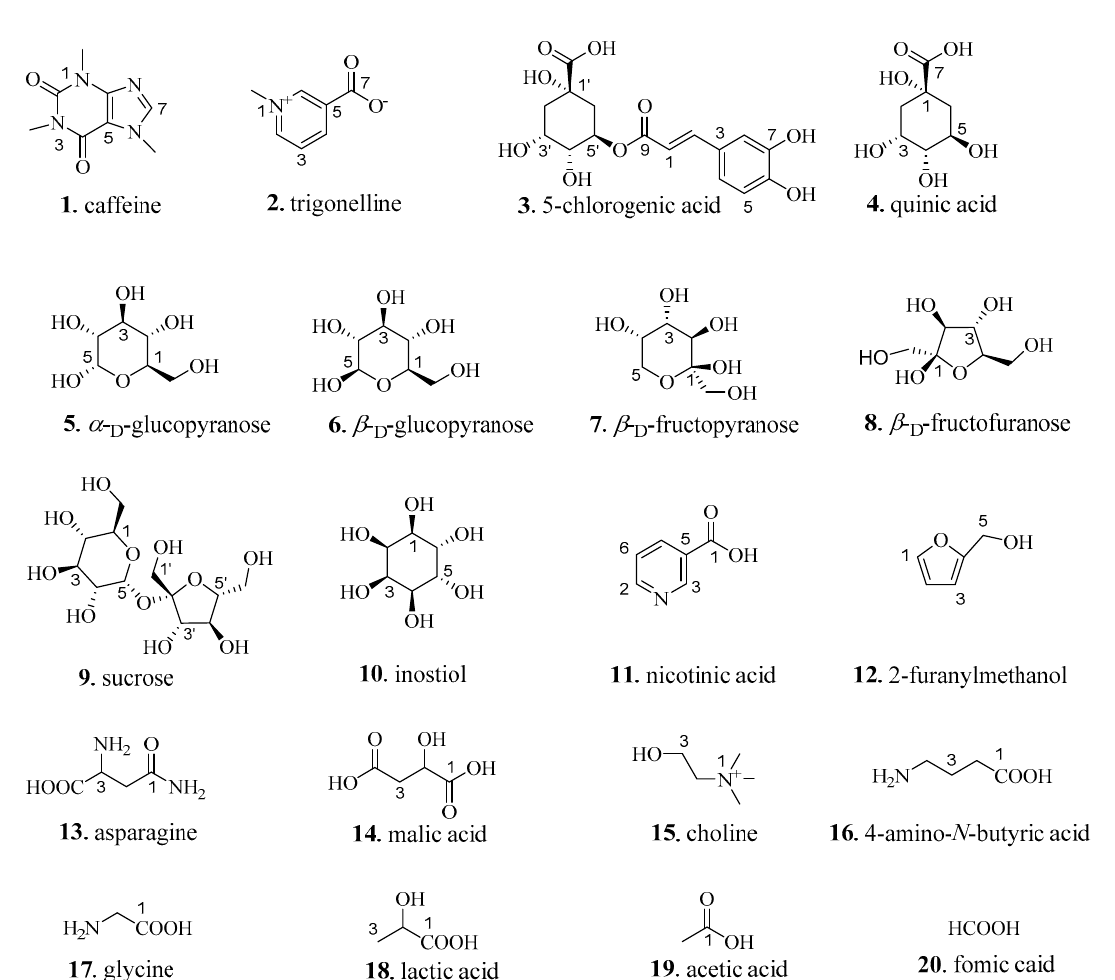
Figure 2. The compounds ( 1 - 20 ) of CS aqueous extract were identified by 2D NMR